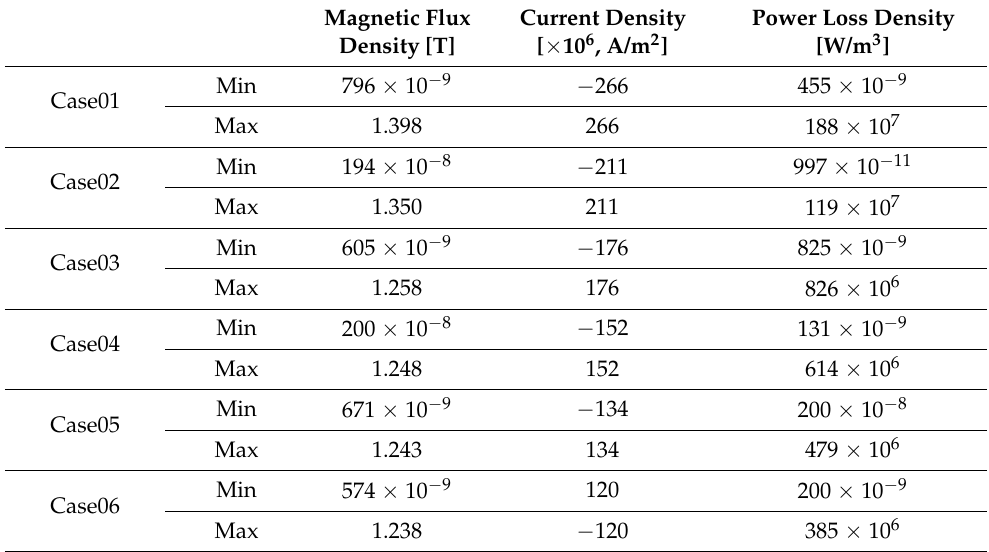
Table 5. Analysis results with different